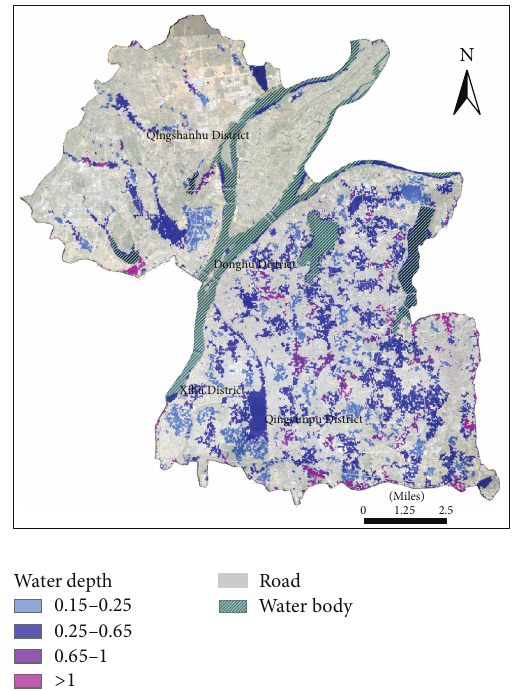
Figure 11: Distribution map of waterlogging in return period of 50 years of Nanchang.